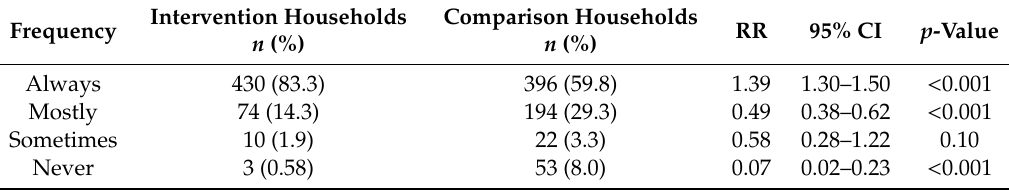
Table 4. Self-reported handwashing with soap after toilet